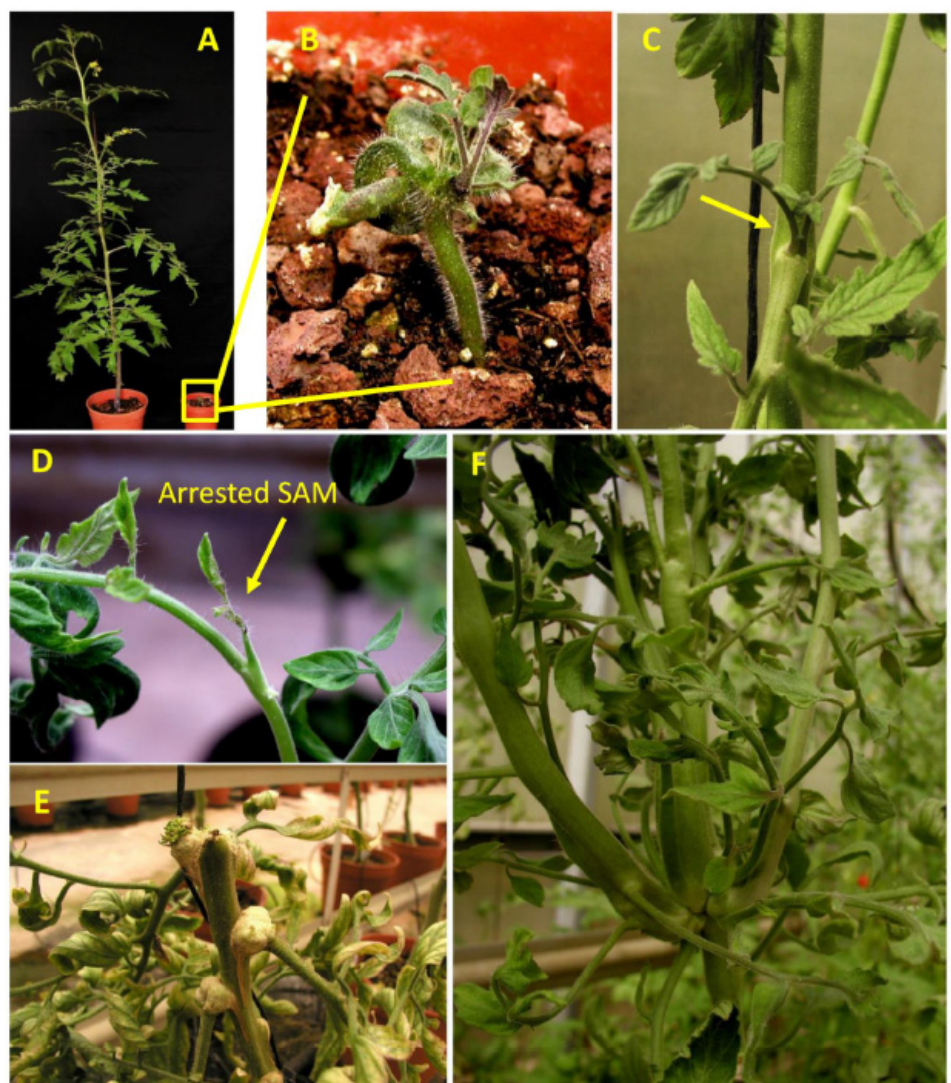
Figure 2. F2 segregating plants from the cross between sus and frk exhibited a variety of meristematic aberrations. ( A ) Eight-week-old WT (left) and F2 sus/frk segregant (right) whose growth was arrested at an early vegetative phase. ( B ) Enlarged image of the plant is shown in the yellow box in ( A ), indicating shoot apical meristem (SAM) growth arrest. ( C ) Two leaves (yellow arrow) developed from an auxiliary meristem of an F2 segregant instead of a lateral branch. ( D ) SAM growth arrest at the transition to flowering. ( E ) Callus tissue formed from the auxiliary meristems of an F2 sus / frk segregant that underwent SAM growth arrest. ( F ) Abnormal formation of several co-localized lateral branches of an F2 segregant.